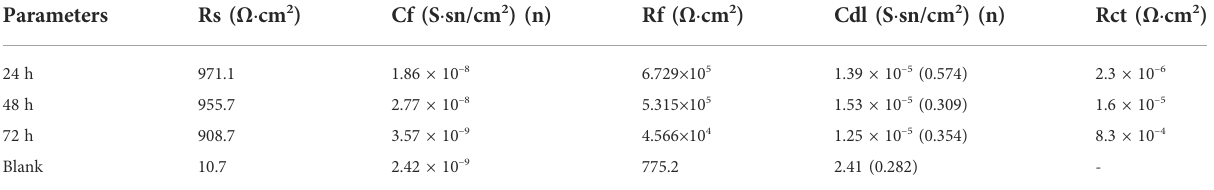
TABLE 4 Electrochemical parameters from EIS equivalent electrical circuits of the specimens.